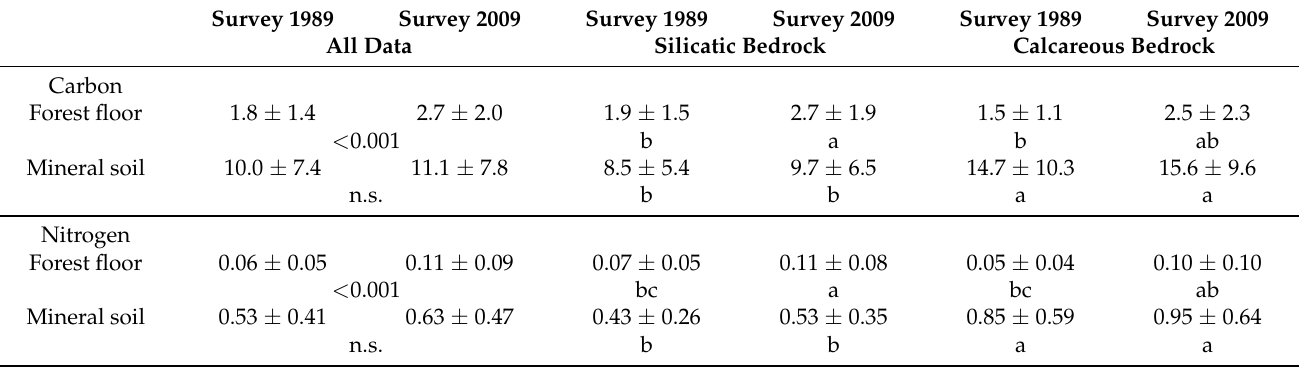
Figure 1. Change of stocks of soil organic carbon and nitrogen in Austrian forest soils within 20 years. Upper panel: Change in the litter layer. Lower panel: Change in the mineral soil to a depth of 50 cm ( left : organic carbon, right : nitrogen). The blue triangles show sites on calcareous bedrock, the red circles sites on silicatic bedrock, respectively. The lines indicate the linear regression functions. Table 2. Stocks of soil organic carbon and nitrogen (kgm − 2 ) in the organic surface layer and the upper 50 cm of the mineral soil. Statistical differences between the two soil surveys are given by the p -values; differences between the strata ‘survey’ and ‘bedrock’ are shown by letters that indicate the grouping according to a comparison of means (Tukey